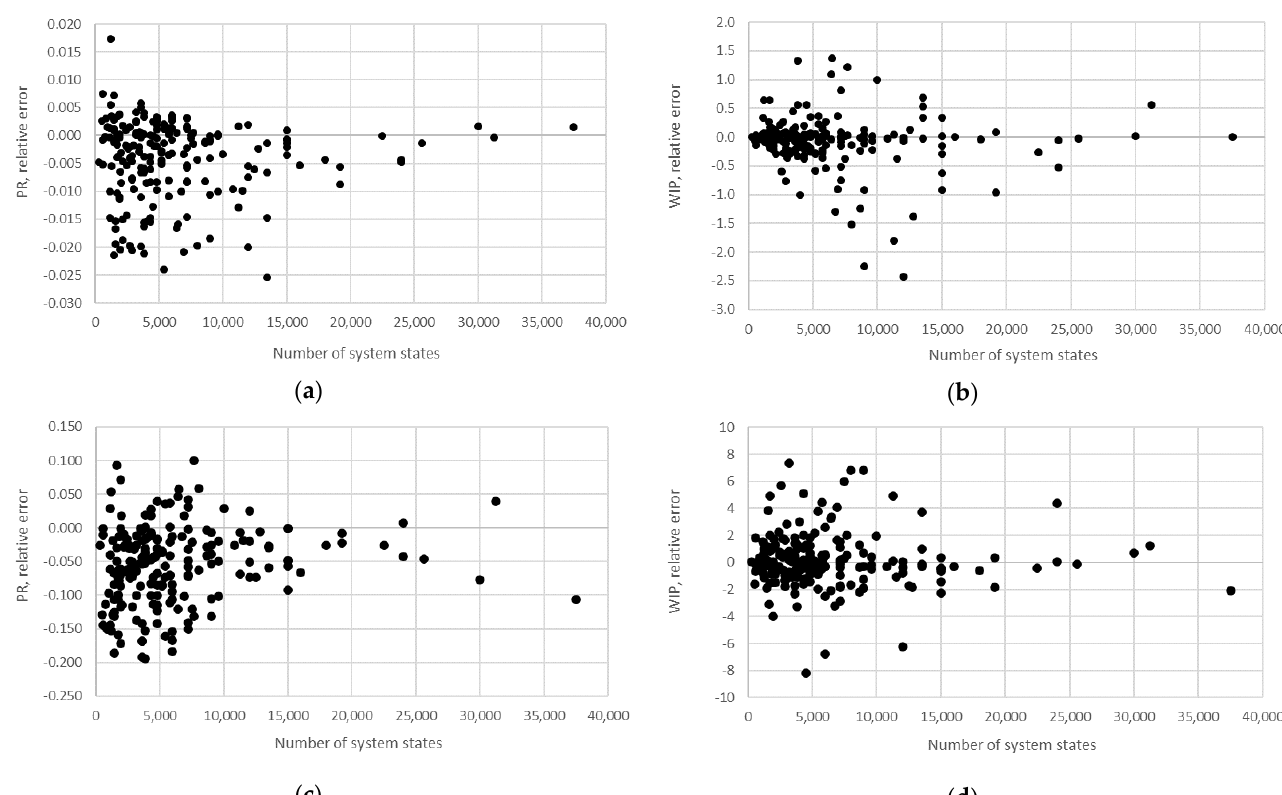
Figure 16. M = 7, relative error obtained using the ( a , b ) AGG procedure and ( c , d ) FSM.